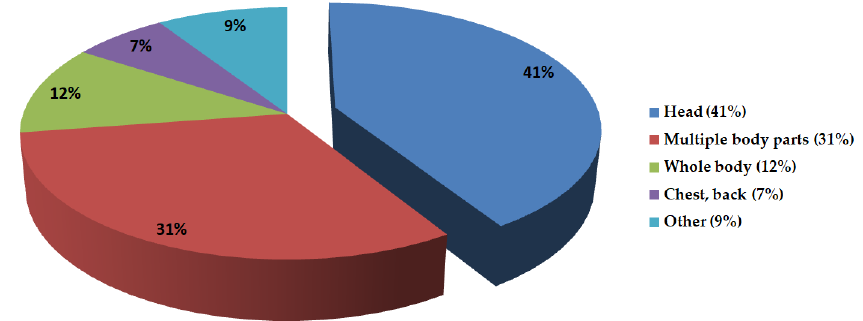
Figure 2. Distribution of accidents in the construction industry in Korea by injured body part.